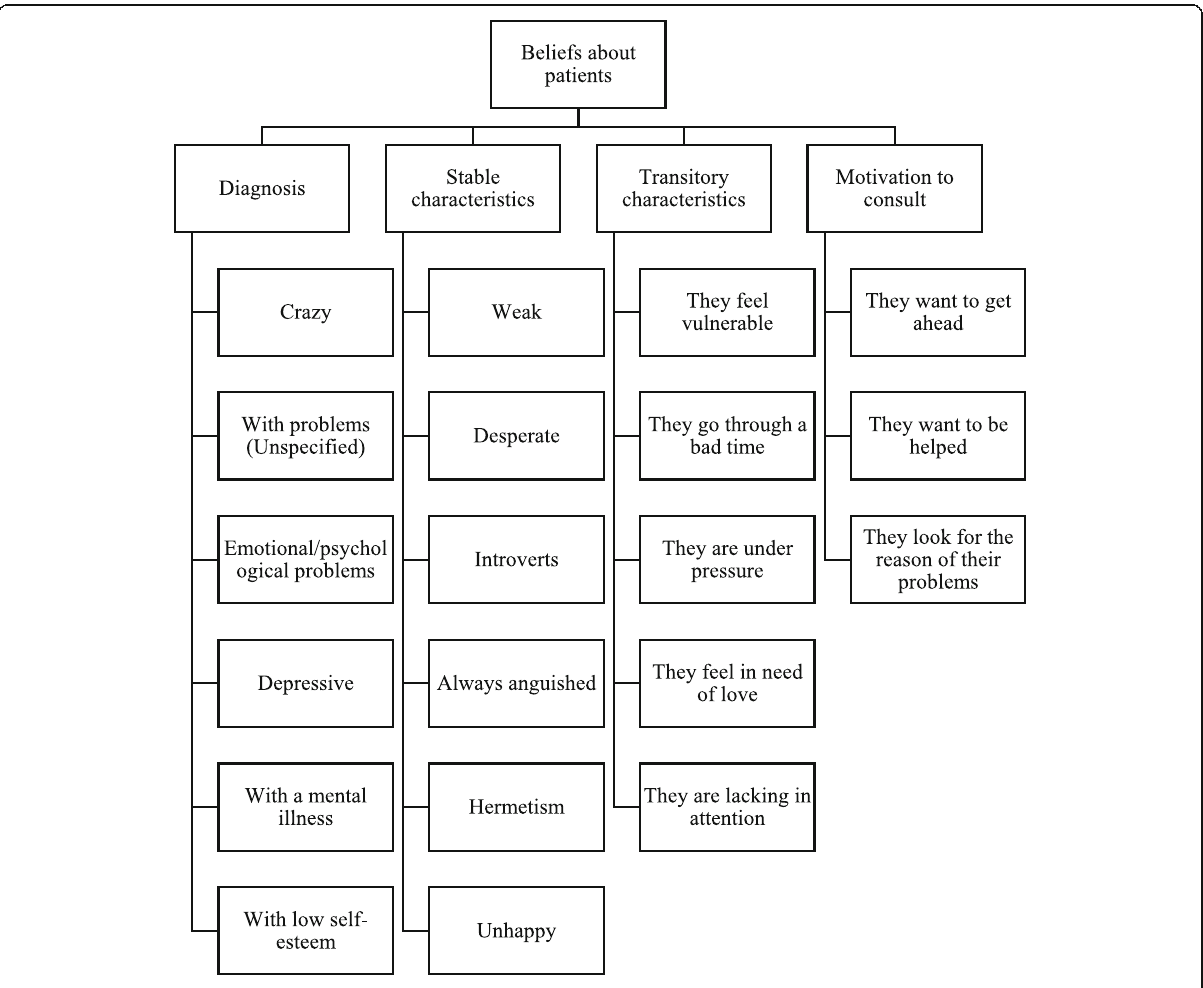
Fig. 1 Thematic analysis of cultural beliefs about psychotherapy patients, bottom-up — phase